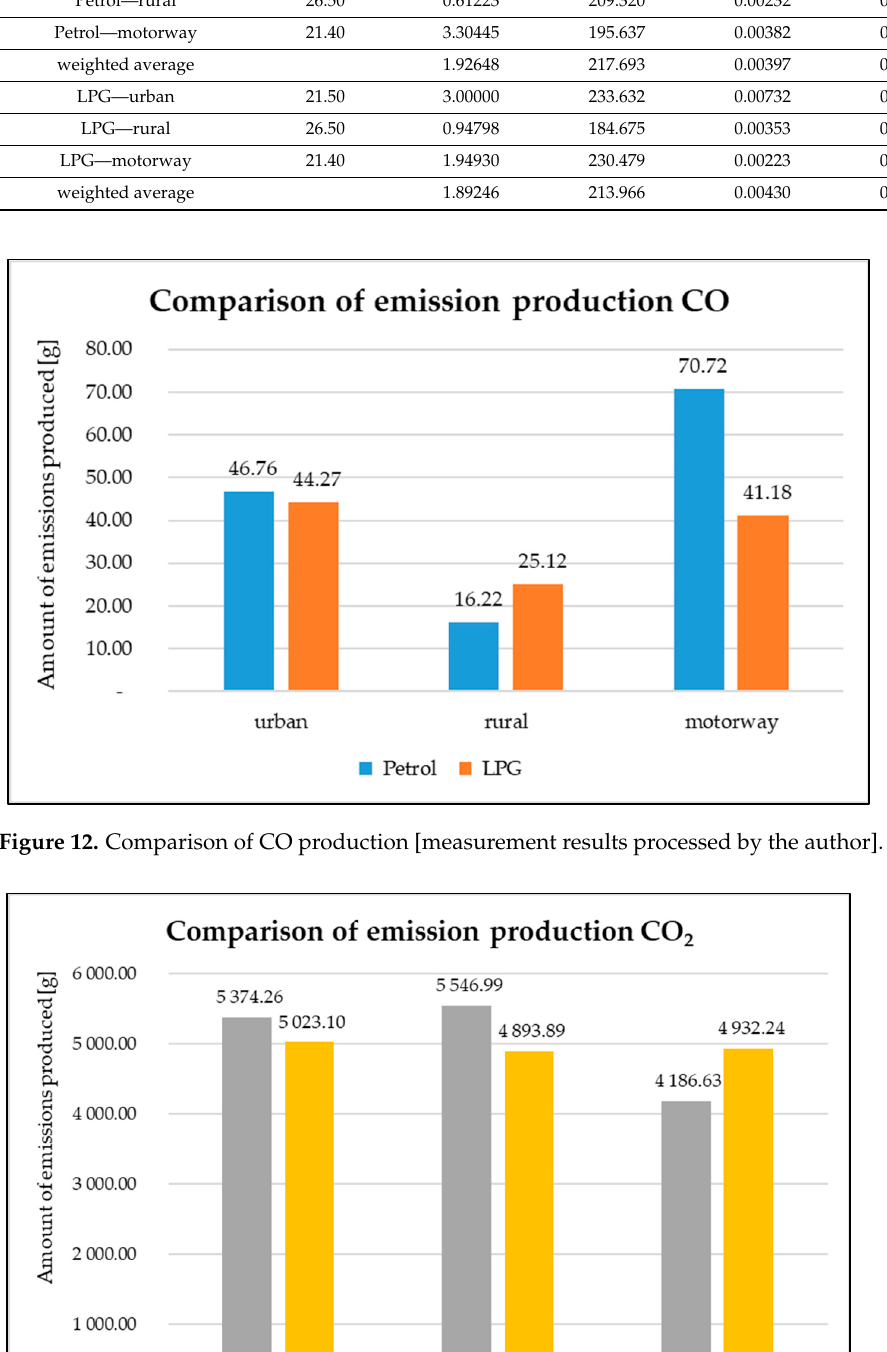
Figure 14. Comparison of HC production [measurement results processed by the author].